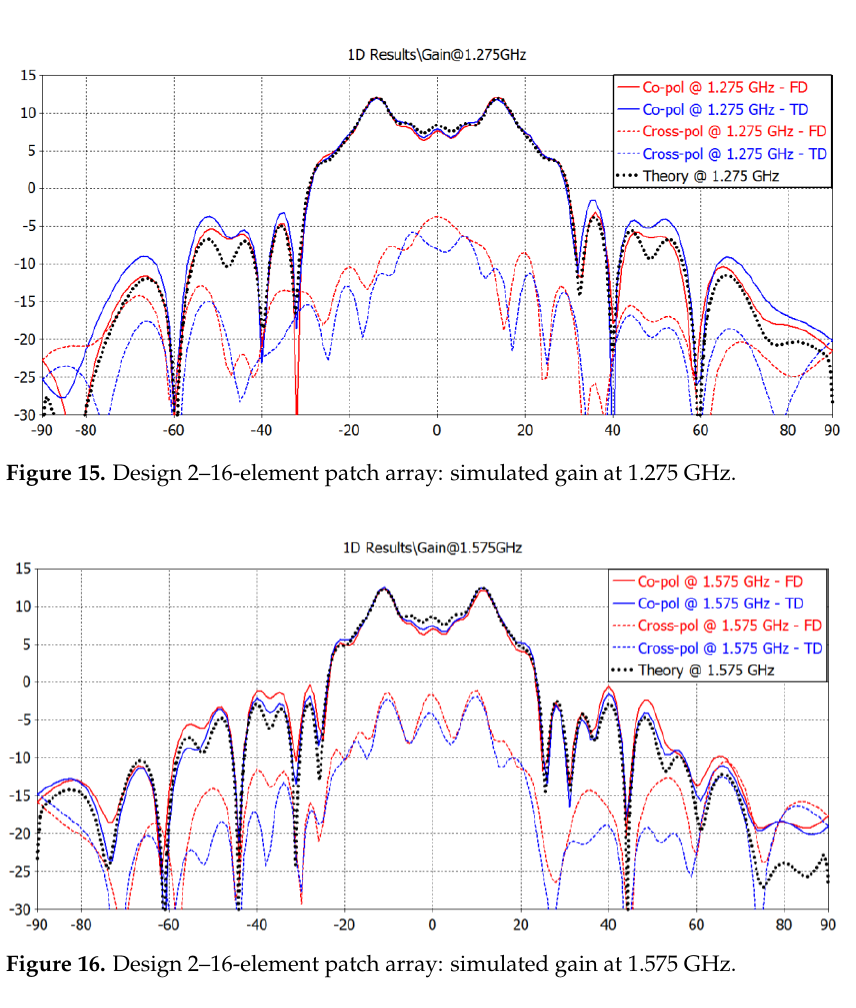
Figure 14. Design 2 – 16-element patch array: simulated reflection coefficient.